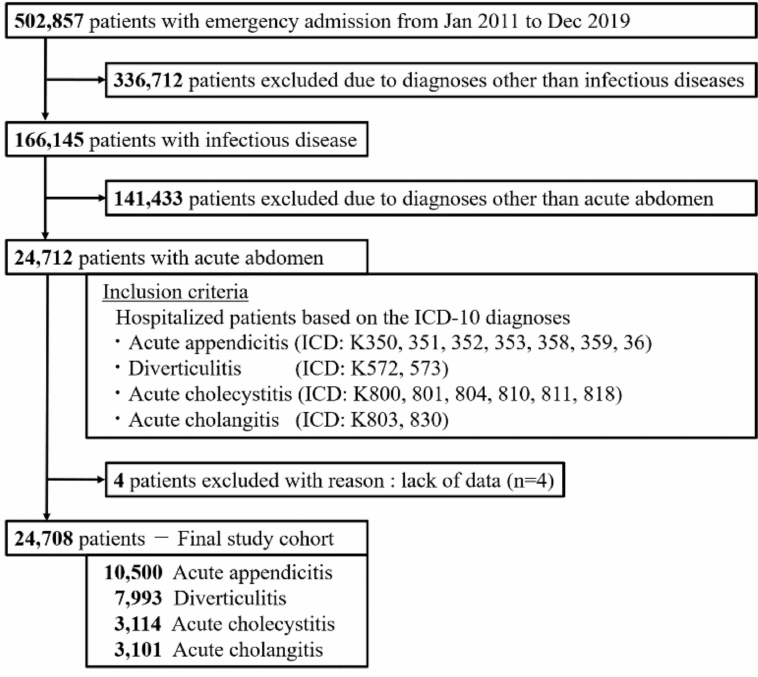
Figure 1. Patient flow. Flowchart of patients admitted to this study from 2011 to